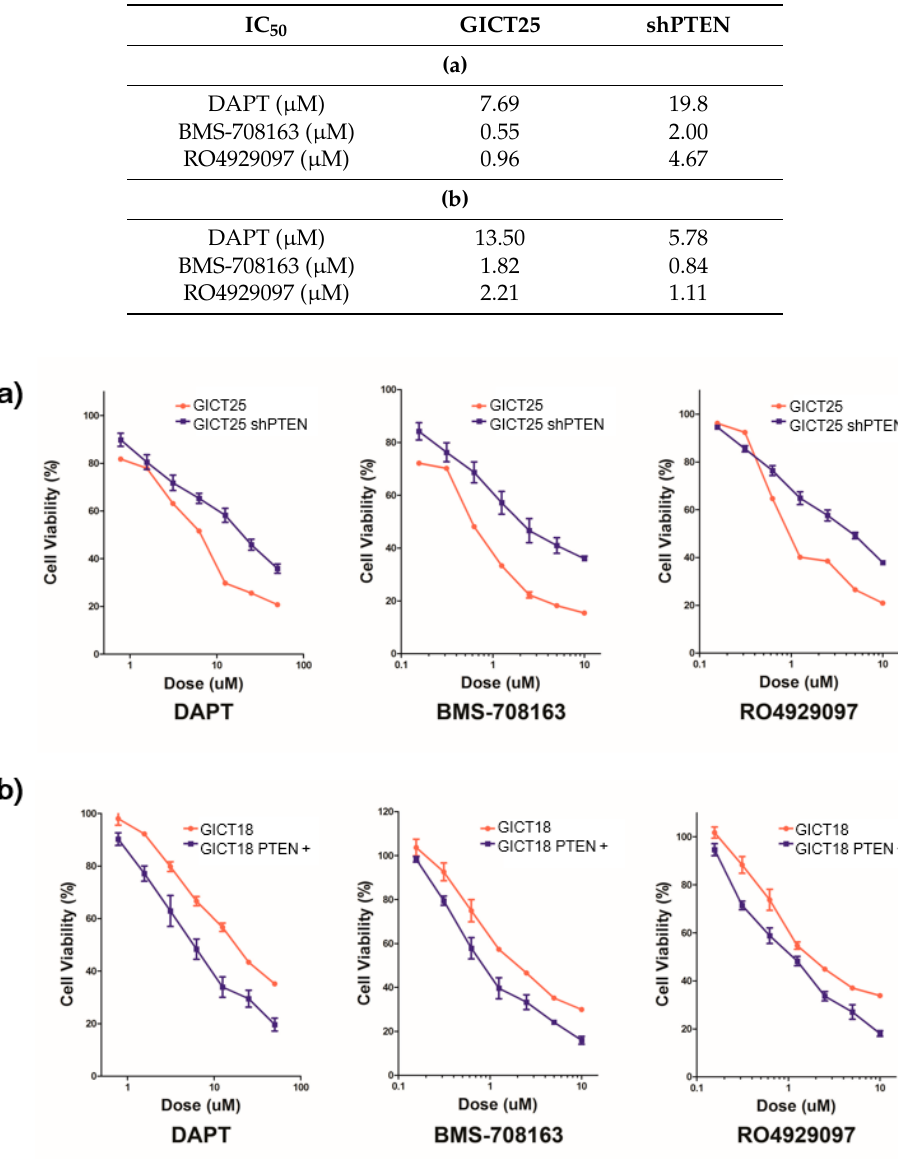
Figure 4. PTEN expression is required for the GSI response in cell growth inhibition. ( a ) PTEN knockdown decreased the response to GSI in PTEN–wild ‐ type GIC; ( b ) PTEN expression increased the response to GSI in PTEN ‐ mutant GIC.